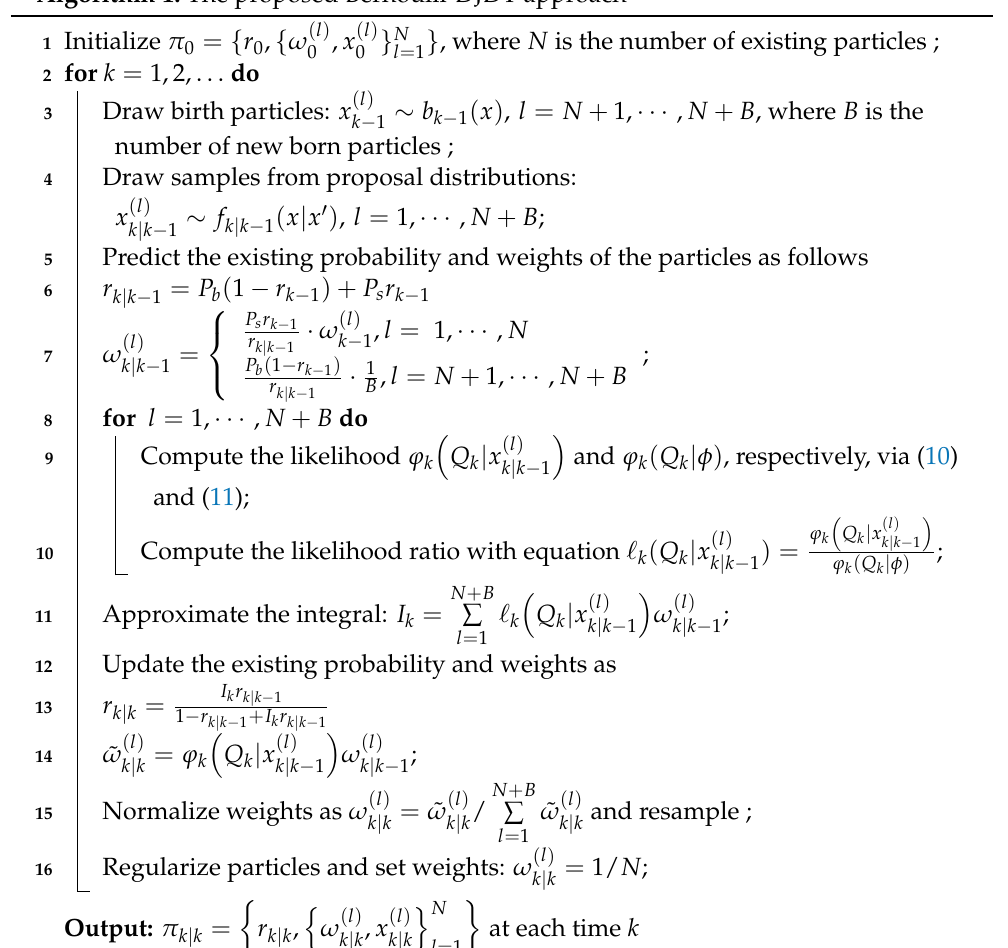
Algorithm 1: The proposed Bernoulli-DJDT